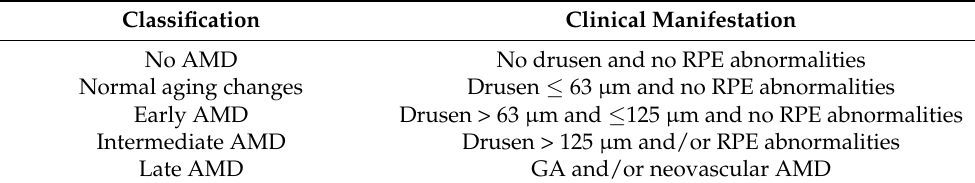
Table 1. The Beckman clinical classification of age-related macular degeneration (AMD) [41] . Classification